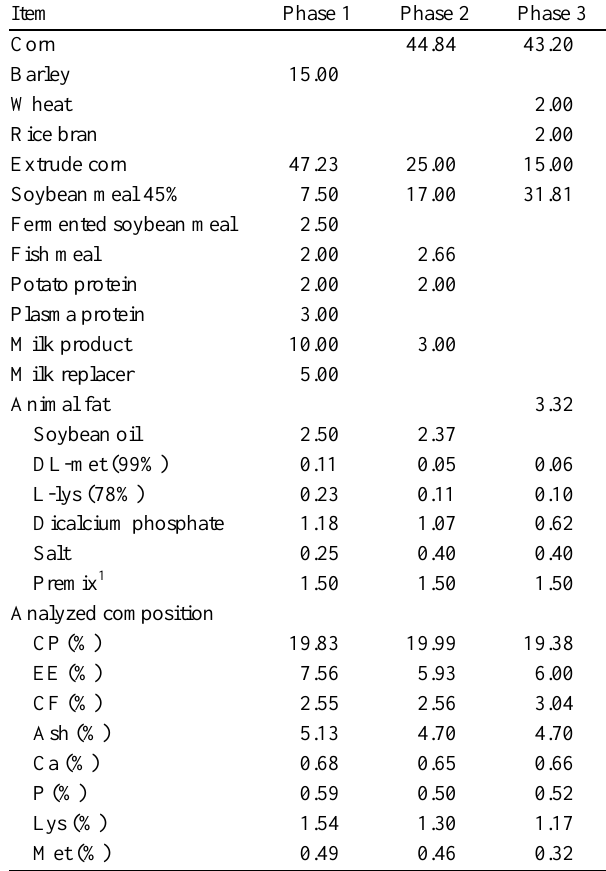
Table 1. Compositions of basal nursery pig diets for Exp. 1 and